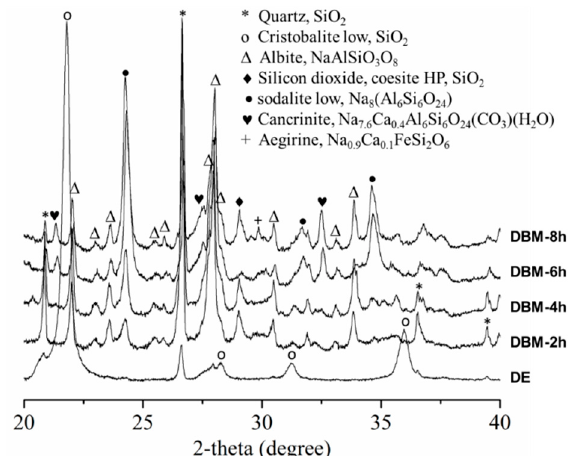
Figure 3. X-ray diffraction (XRD) diffractograms of DE and DBM after hydrothermal treatment for 2, 4, 6, and 8 h.